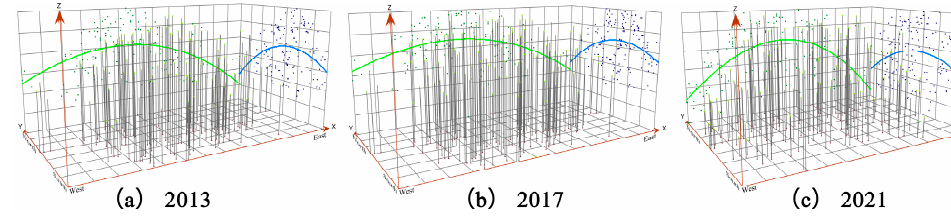
Figure 3. ( a ) Diagram of the built-up zone growth–decline area; (( b1 )–( b3 )) LUQ in 2013/2017/2021.